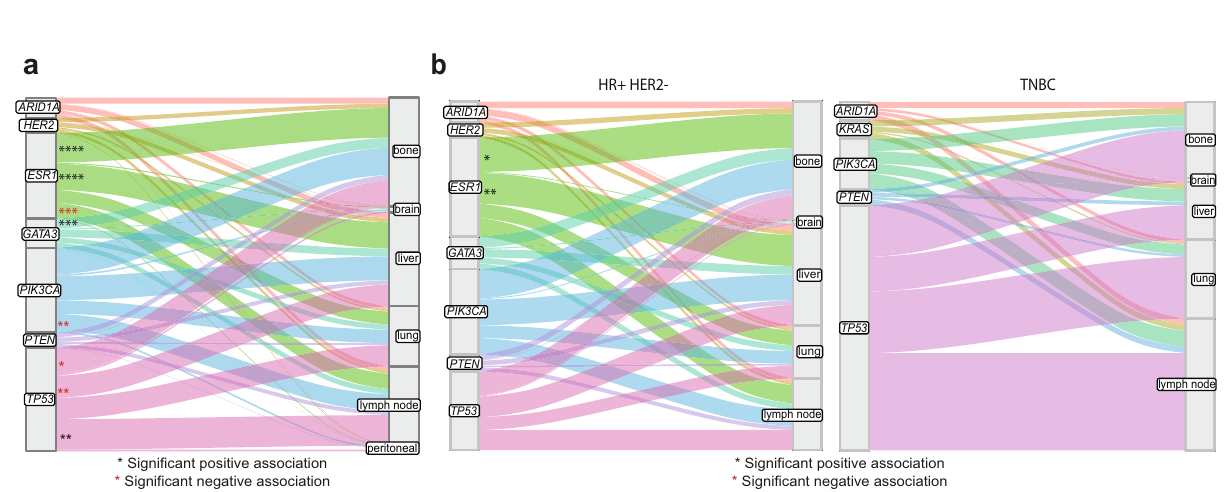
Fig. 3 Clinical and pathological associations of breast cancer mutation pro fi le. a Association of number of mutations (SNVs/indels, left ) and the maximum variant allele frequency (mVAF, right , as a proxy of ctDNA purity) with indicated clinical and pathological features. p values from pairwise two- sided Kruskal – Wallis test with correction for multiple testing (number of mutations: HR + HER2- vs TNBC q = 0.008; 0 vs ≥ 5 lines of treatment q = 0.0005, 1 – 2 vs ≥ 5 lines of treatment q = 0.0005; 0 vs ≥ 3 lines of chemotherapy q = 0.003. mVAF: 0 vs ≥ 5 lines of treatment q = 0.03, 1 – 2 vs ≥ 5 lines of treatment q = 0.006; 0 vs 1 – 2 lines of chemotherapy q = 0.003, 0 vs ≥ 3 lines of chemotherapy q = 0.0003; soft tissue/nodal vs visceral disease q = 0.002). MBC, metastatic breast cancer; CTx, chemotherapy; IDC, invasive ductal carcinoma; ILC, invasive lobular carcinoma. b Association of clinical and pathological features with pathogenic alterations in the four targetable genes in plasmaMATCH: PIK3CA, ESR1, HER2 and AKT1 . p -values from Chi-squared